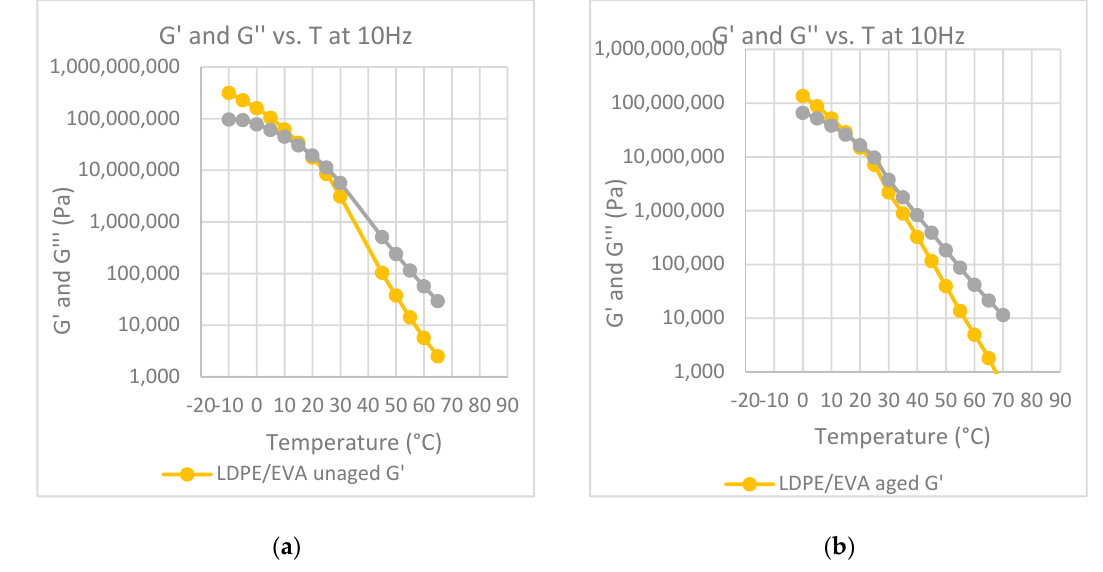
Figure 9. Elastic modulus, G ′ and loss modulus, G ′′ , at 10 Hz, as a function of temperature: ( a ) binder modified with LDPE-LLDPE-EVA before aging; ( b ) binder modified LDPE-LLDPE-EVA after aging at the RTFOT.